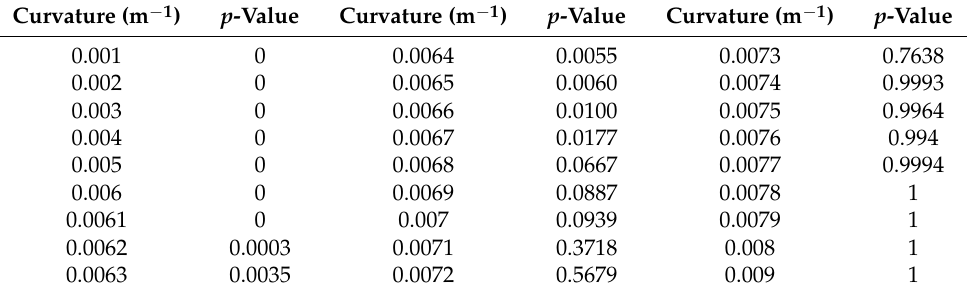
Table 4. Mann–Whitney U test for simulated curvy roads (or